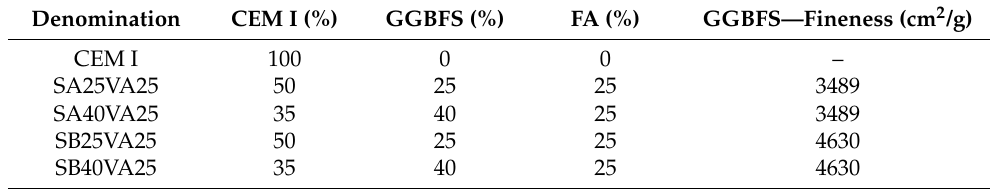
Table 2. Ternary cement mix design.